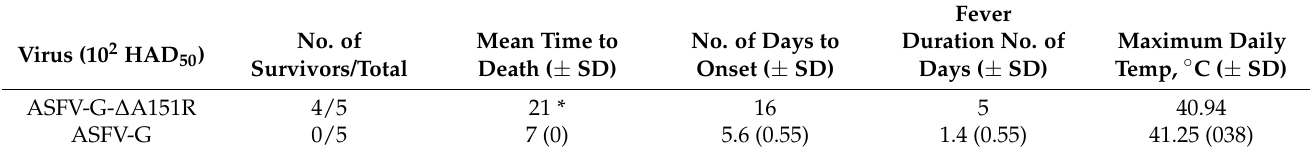
Table 1. Swine survival and fever response following infection with ASFV-G- ∆ A151R and parental ASFV-G.